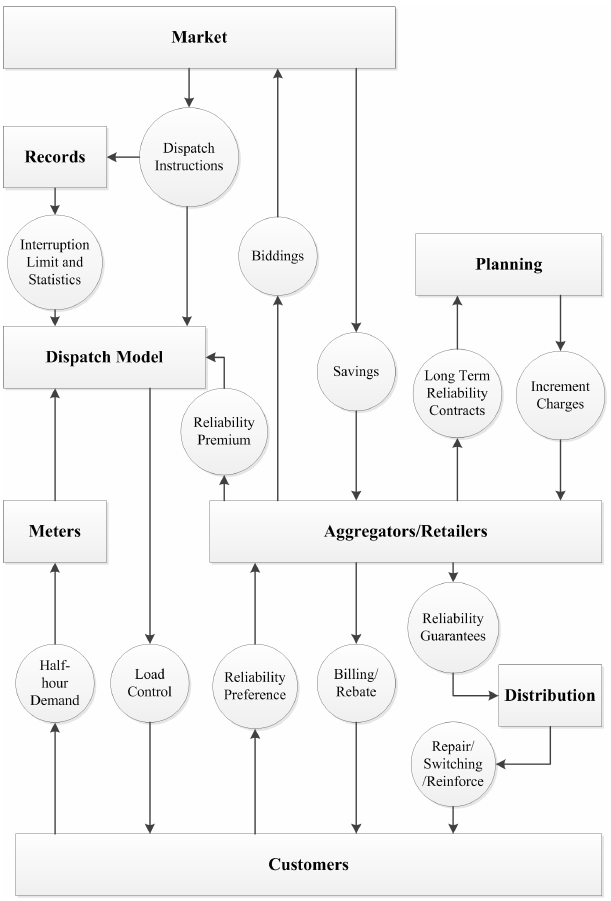
Figure 2. Processes of utilising load point reliability